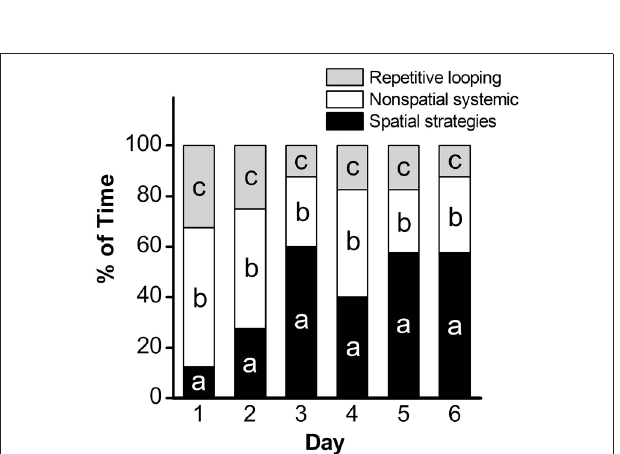
FIGURE 2 | Assessment of search strategy in the acquisition phase of the MWM. The percentage of time engaged in specific search strategies during the 60-s trial was calculated, with search strategies combined into 3 groups based on functional similarity (repetitive looping, nonspatial systemic strategies, and spatial strategies) and analyzed using Chi Square. a: p < 0.001 ; b: p = 0.001 ; c: p = 0.02 . n = 10 .